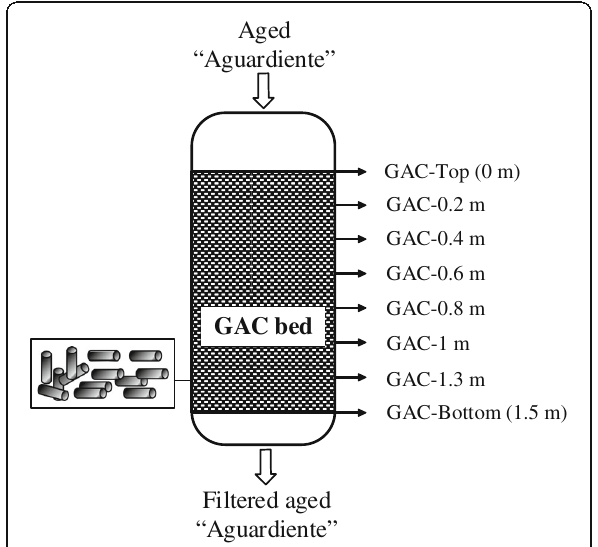
Fig. 3 Simplified schematic diagram of the rum filter and the samples location from different GAC